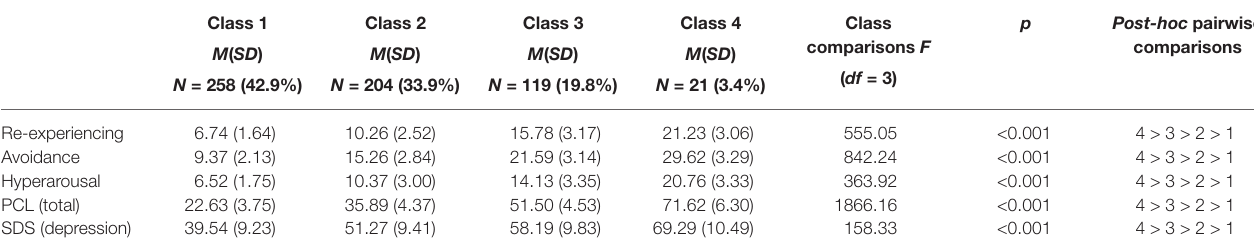
TABLE 2 | Unstandardized class means for four-class model.